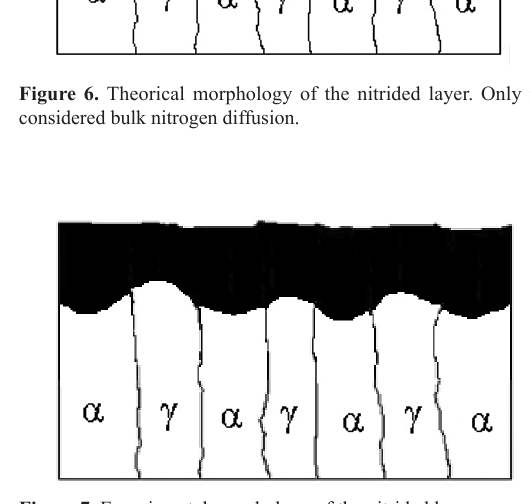
Figure 7. Experimental morphology of the nitrided